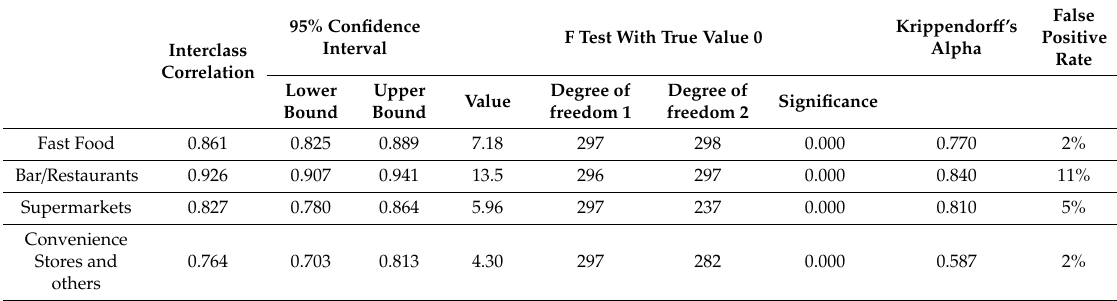
Table 2. Intra-class correlation coe ffi cients calculated using a mean-rating (k = 2), absolute-agreement, two-way mixed-e ff ects model. Sample after correcting for